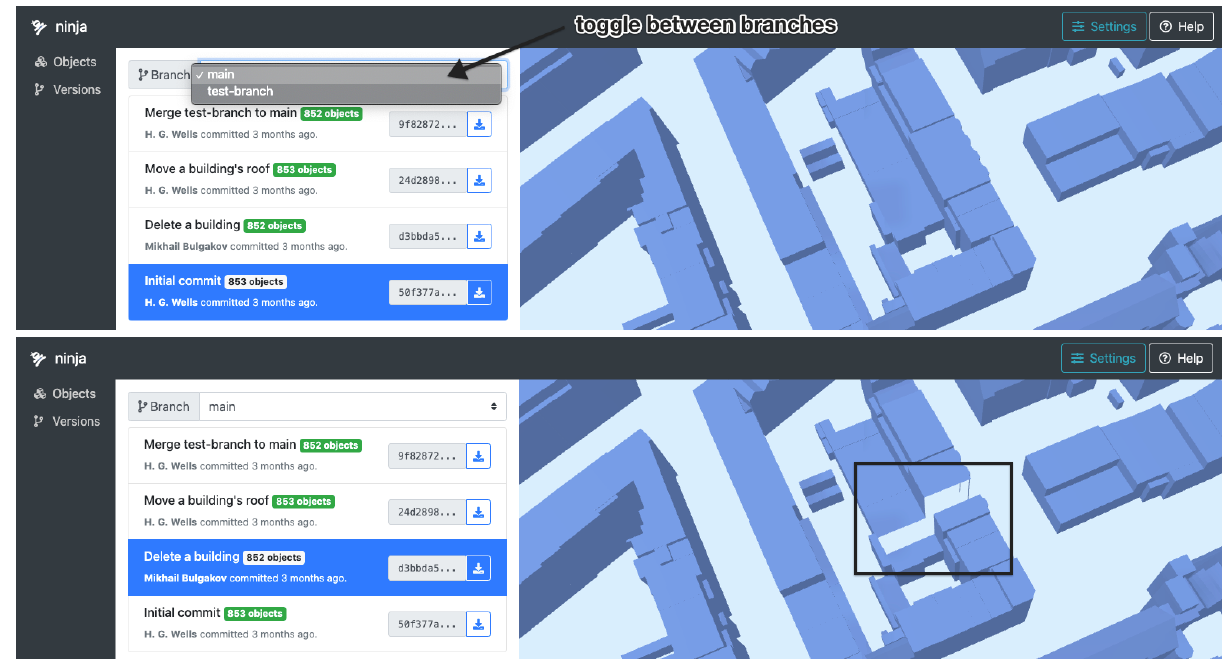
Figure 3. An example of versioning in ninja . The image at the top demonstrates the ability to toggle between different branches. It also has the the model at the state in which it was first versioned. The image below shows a different version of the model, in this case a building was deleted.